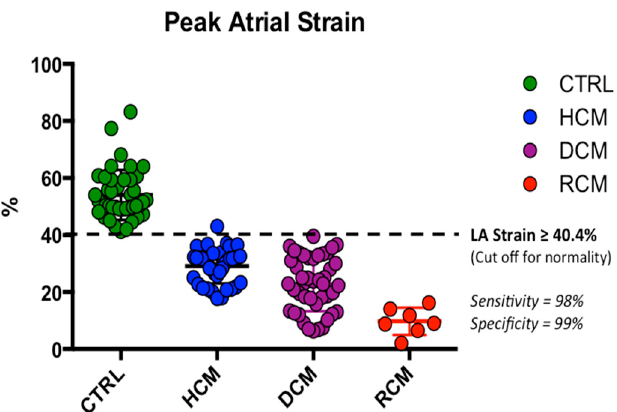
Figure 5. LA Strain cut-off to differentiate normal diastolic function in paediatric age. The dotted line represents the cut-off ( ≥ 40.4%; sensitivity, 98%; specificity, 99%) obtained to differentiate children with normal diastolic function (green dots), from those with HCM (blue dots), DCM (purple dots), RCM (red dots). CTRL: normal controls. HCM: Hypertrophic Cardiomyopathy. DCM: Dilated Cardiomyopathy. RCM: Restrictive Cardiomyopathy. LA: Left Atrial.